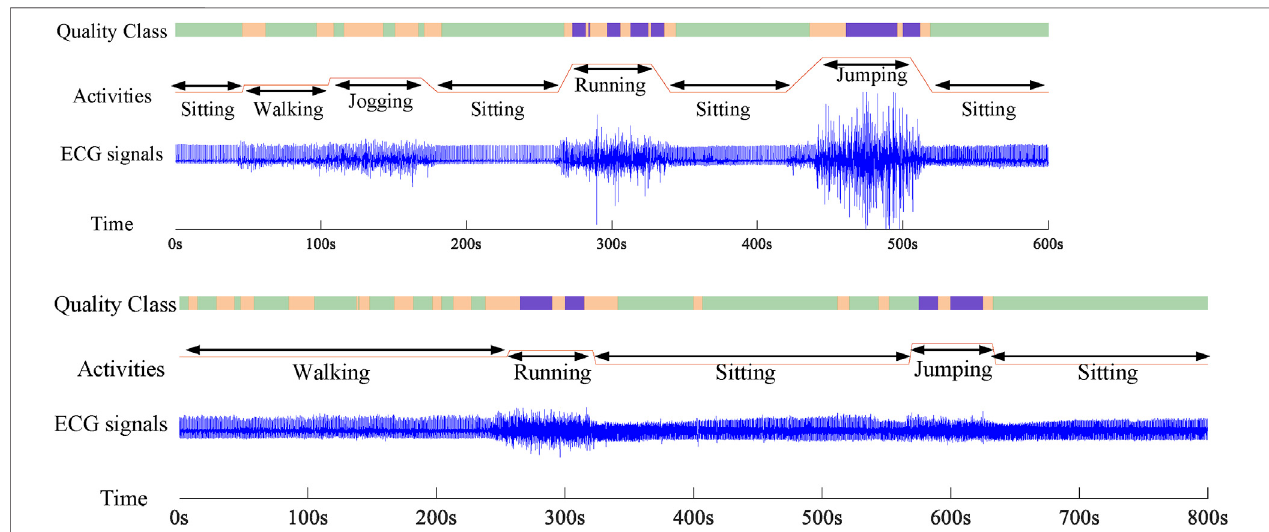
FIGURE 8 | Two records about 10-min duration of dynamical ECG signals, physical activities, and evaluation results.